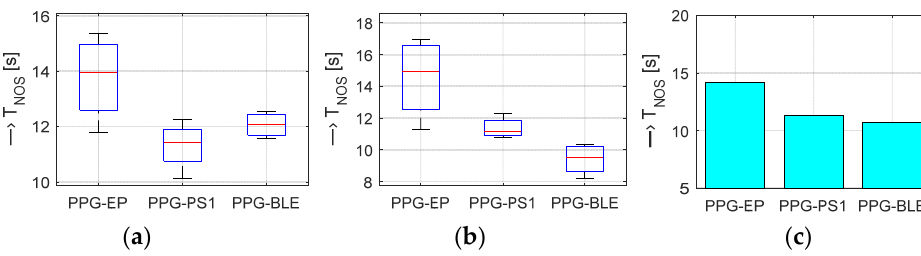
Figure 13. Statistical comparison of T NOS time intervals for tested PPG sensors: ( a ) boxplot of T NOS